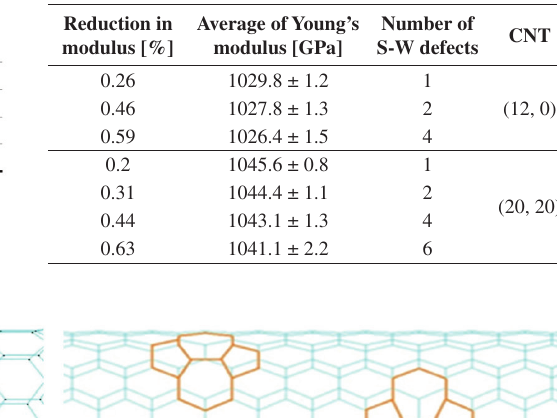
Table 3. Young’s modulus of CNTs containing Stone-Wales